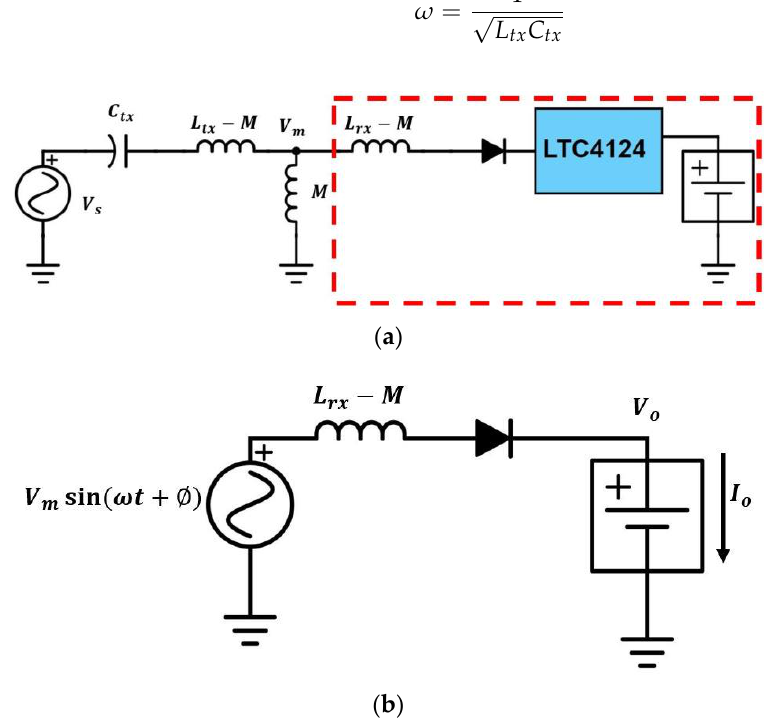
Figure 12. ( a ) Equivalent circuit for the wireless-charging hanger system; ( b ) equivalent circuit for the RX (dash block in ( a )).